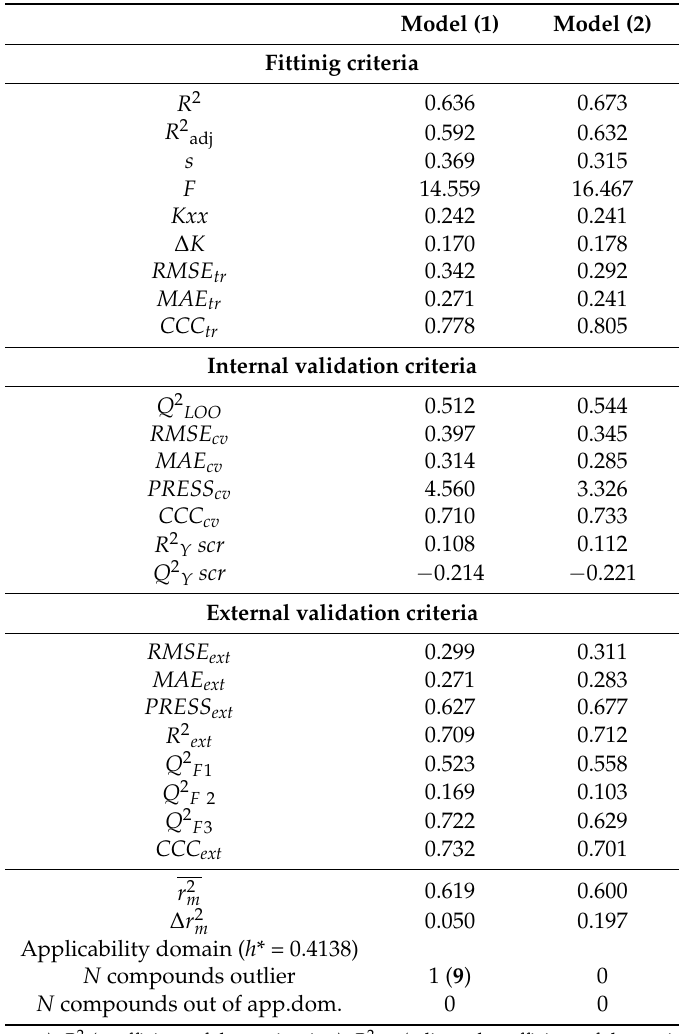
Table 2. The model statistical results for the QSAR for antioxidant